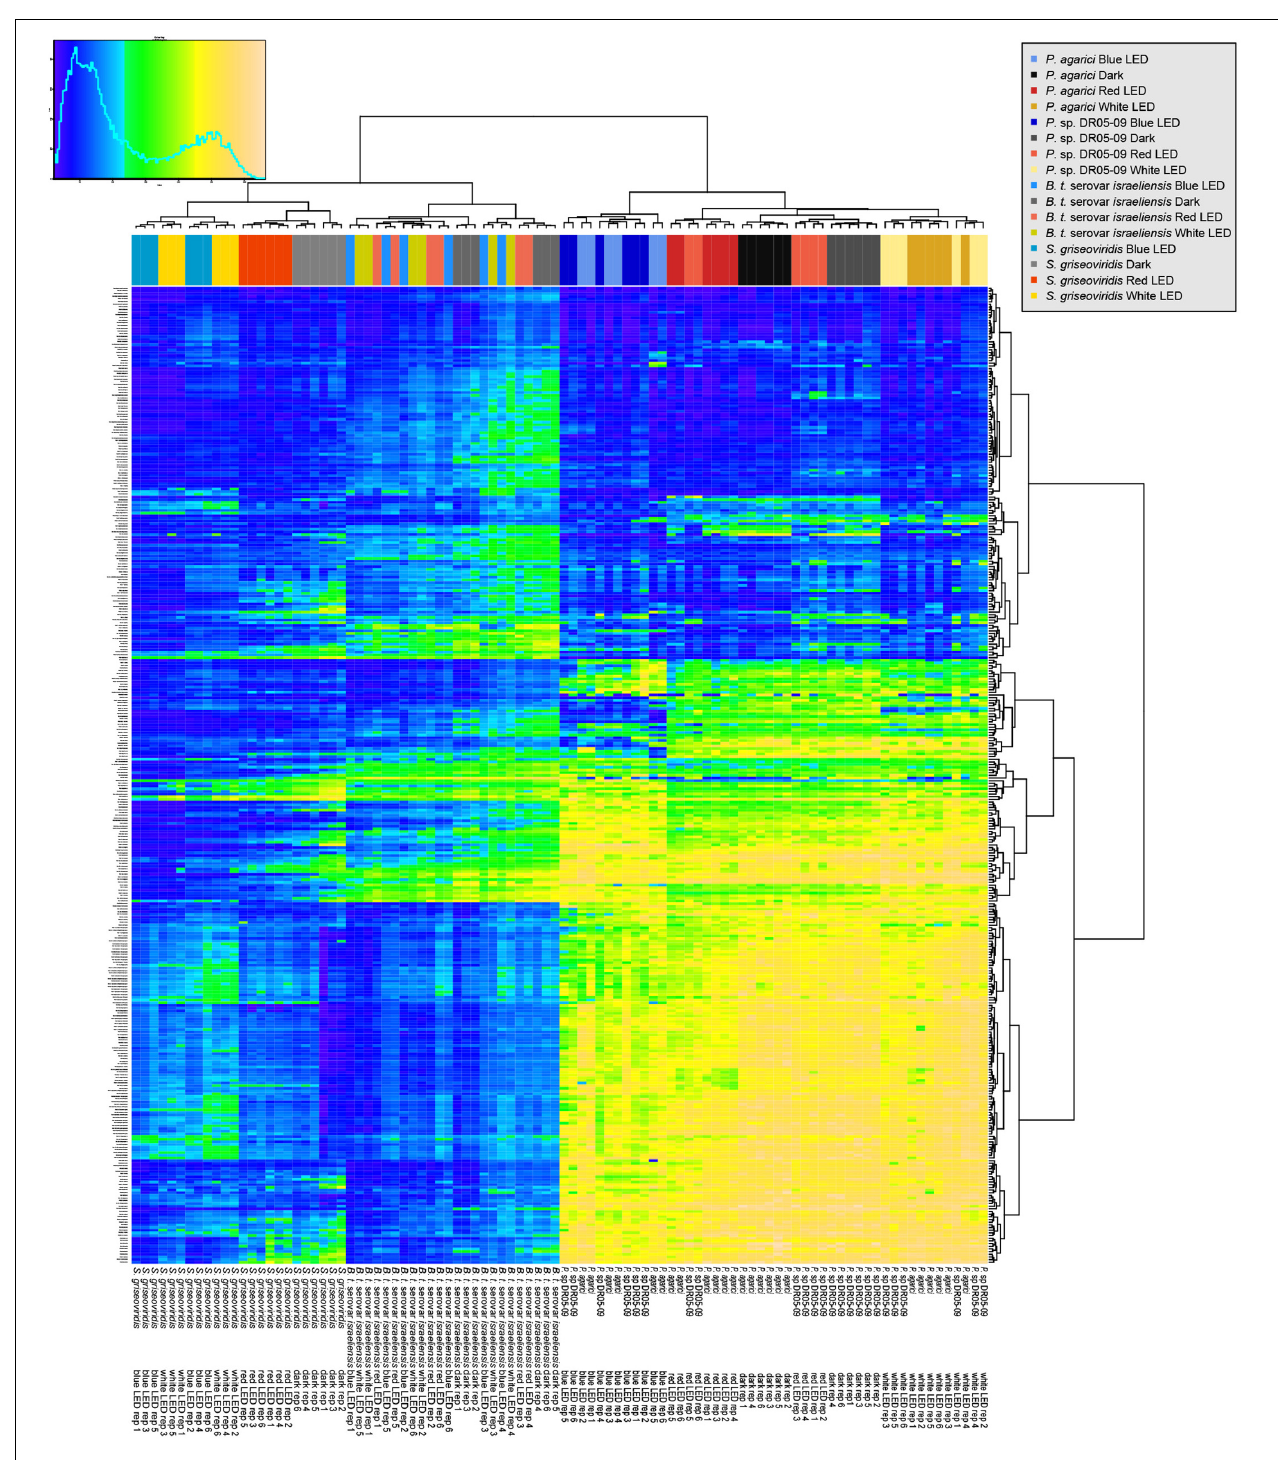
FIGURE 1 | Overview of respiration behavior of Pseudomonas agarici (strain 1), Pseudomonas sp. DR 5-09 (strain 2), Bacillus thuringiensi s serovar israeliensis (strain 3), and Streptomyces griseoviridis (strain 4) on 190 carbon (C), 95 nitrogen (N), 59 phosphorus (P), and 35 sulfur (S) sources. The heatmap displays maximum curve height values monitored during 96 h (strain 1–3) and 192 h (strain 4) when exposed to blue, red, or white LEDs or darkness. The legend ( upper left corner ) explains the color code from blue to green, while yellow shades indicate low, moderate, and high substrate utilization, assessed as arbitrary Omnilog values. The histogram describes the frequency of maximum height reached for the various